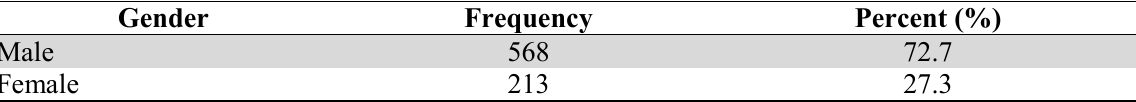
Gender of Respondents